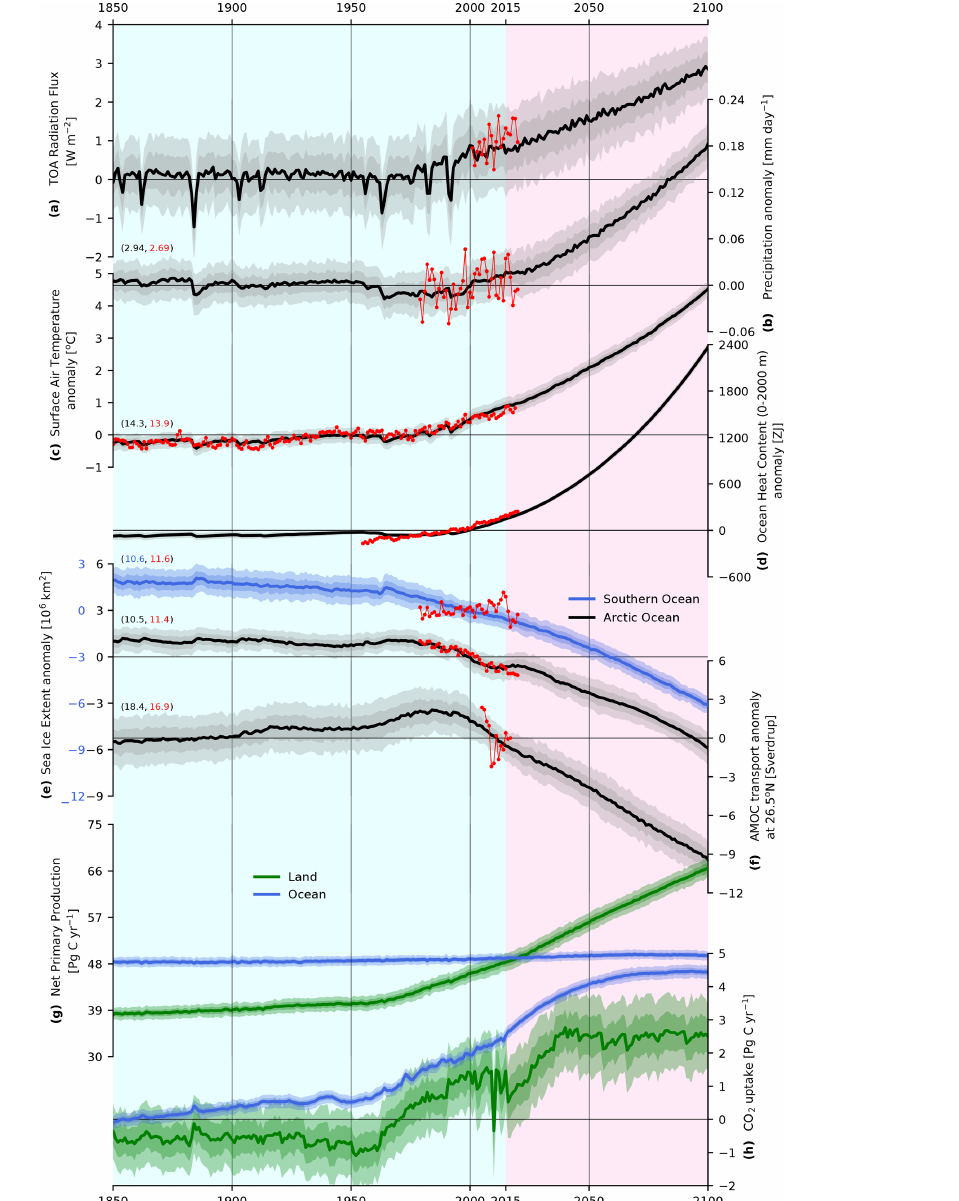
Figure 1. Annual mean evolution of global fields over 1850–2100 for 100 ensemble members. For model fields, bold lines represent ensemble means, and dark and light shading represent 1 standard deviation (SD) and 2 SD variability. Observational data are shown in red when appropriate. Portions of the figure with light-blue background shading indicate the historical period (1850–2014) while portions with light- red background shading indicate the projection period (2015–2100). (a) Top-of-atmosphere radiative imbalance (Wm − 2 ) along with the CERES-EBAF product (Loeb et al., 2009, 2018); (b) anomalies of the global mean precipitation (mmd − 1 ) increasing 5.4% between the 1850s and the 2090s, compared with the Global Precipitation Climatology Project (GPCP) (Adler et al., 2003, 2012); (c) anomalies of global mean surface temperature, increasing by 4.4 ◦ C between the 1850s and 2090s, along with HadCRUT4 (Morice et al., 2012) anomalies over 1950–2019; (d) anomalies of ocean heat content integrated over the upper 2000m, along with an observation-based product (Ishii et al., 2017); (e) anomalies of sea ice extent for the Arctic (black) and Southern Ocean (blue), with observed sea ice extent over 1979–2020 (Fetterer et al., 2017), and with the vertical scales of the anomaly plots offset to facilitate comparison; (f) Atlantic Meridional Overturning Circulation (AMOC) transport anomalies at 26.5 ◦ N, with RAPID array observations (Frajka-Williams et al., 2019); (g) globally integrated net primary productivity (NPP) over the ocean (blue; increase of 2.7% between the 1850s and 2090s), and over land (green); and (h) globally integrated net CO 2 fluxes over the ocean (solid blue) and integrated net CO 2 flux (net biome production, or NBP, including fire and land-use change) over land (green) with all quantities in (g) and (h) in units of PgCyr − 1 . For each case, where observational products are included, anomalies are calculated with respect to the period spanned by the observations. For anomaly fields, printed numbers represent the absolute mean of the ensemble mean of CESM2-LE (black or blue numbers) and the observational product (red numbers). https://doi.org/10.5194/esd-12-1393-2021 Earth Syst. Dynam., 12, 1393–1411,